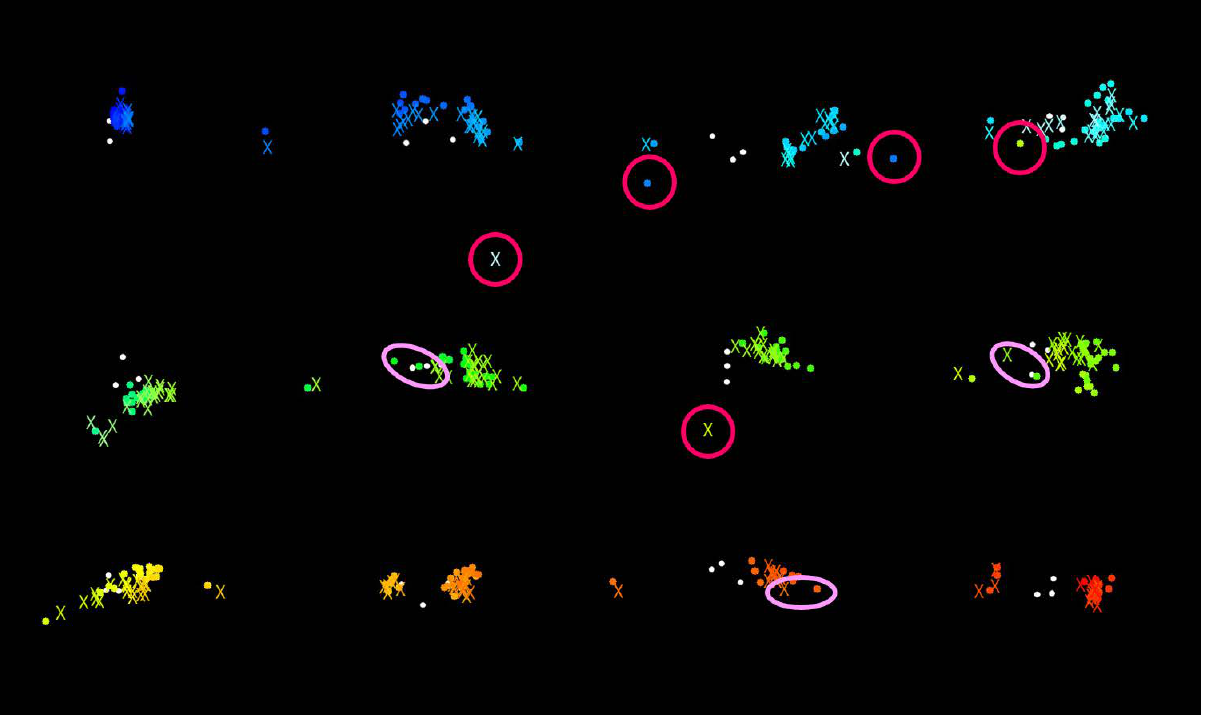
Figure 13: Projected image with eye position mapped (circles: results of template matching, X: results of manual mapping)